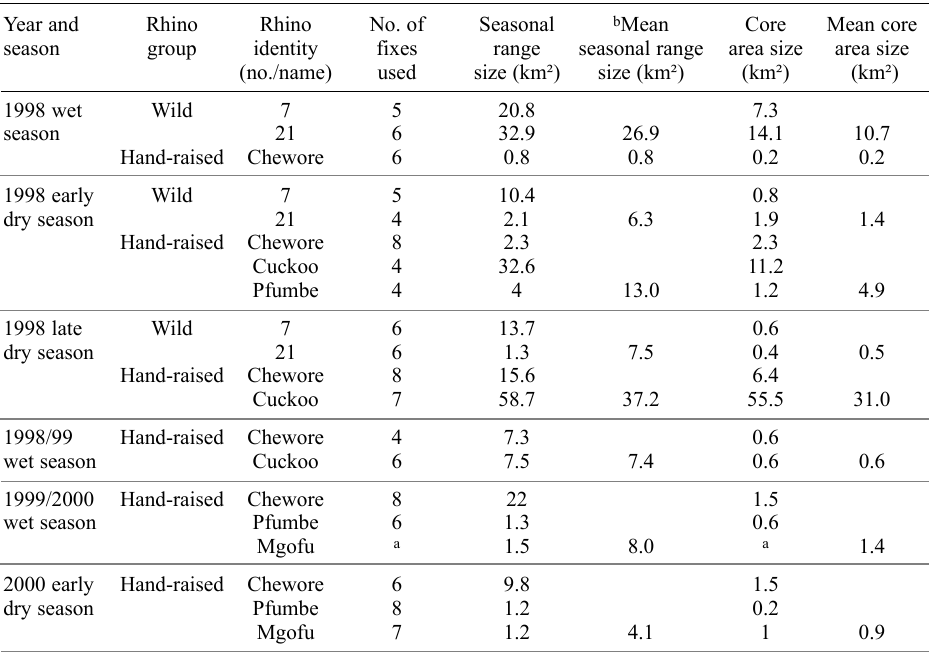
Table 2 Seasonal ranges and core areas of black rhinos in